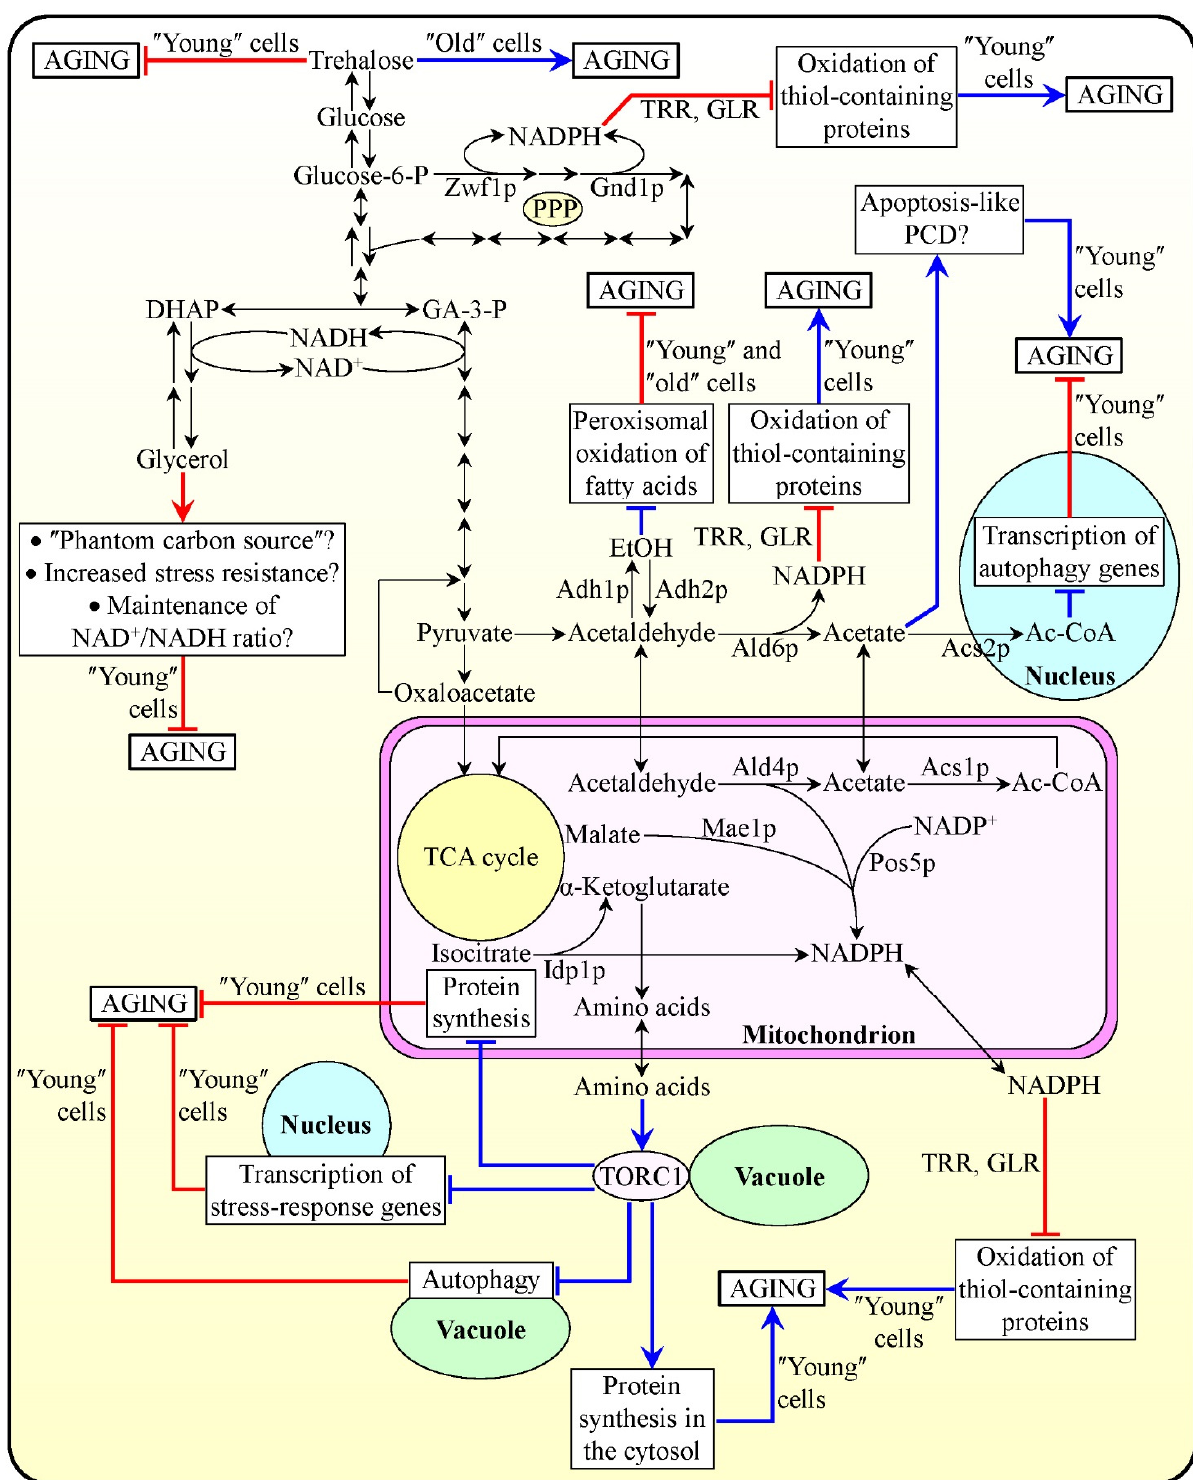
FIGURE 3: The coordinated metabolite flow within glycolytic and non-glycolytic pathways of carbohydrate metabolism defines yeast lon- gevity by modulating vital cellular processes. A model for how metabolic flux within the network integrating glycolytic and non-glycolytic pathways of carbohydrate metabolism in chronologically ″young″, proliferating yeast cells define the development and maintenance of a pro- or anti-aging cellular pattern throughout lifespan, before an arrest of cell growth and division and after such arrest. Activation arrows and inhibition bars denote pro-aging processes (displayed in blue color) or anti-aging processes (displayed in red color). Please see text for additional details. Ac-CoA, acetyl-CoA; DHAP, dihydroxyacetone phosphate; EtOH, ethanol; GA-3-P, glyceraldehyde-3-phosphate; GLR, gluta- thione reductase; PCD, programmed cell death; TCA, tricarboxylic acid; TORC1, target of rapamycin complex 1; TRR, thioredoxin